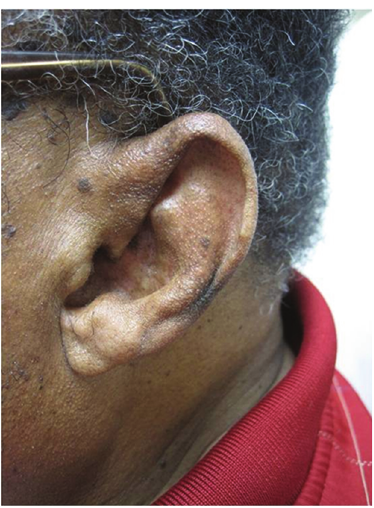
Figure 1: Left ear demonstrating no gross abnormalities. Figure 2: Computed tomography scan of left ear displays partial ossification of the external auricular